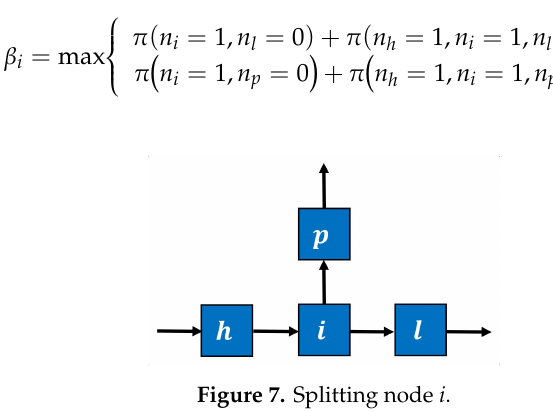
Figure 7. Splitting node i